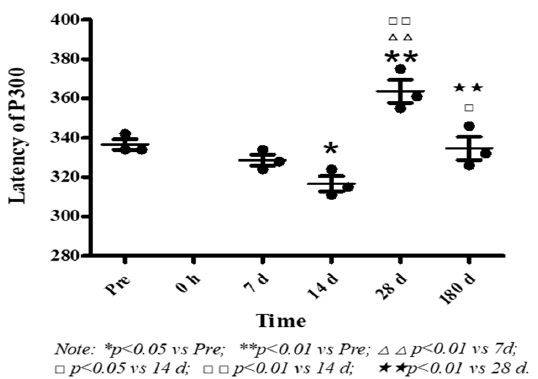
Figure 5. Effects of high level noise on auditory p300 of macaque monkeys.